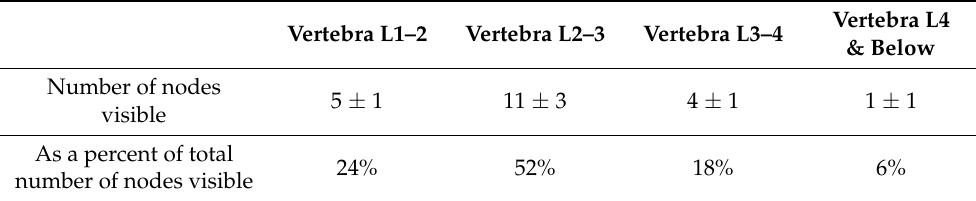
Table 1. Vertebral level of nodes imaged across all time points. Data represent the mean across all participants ±